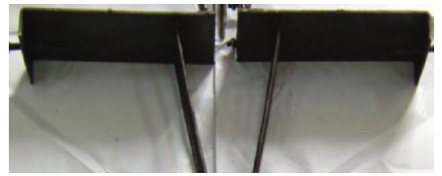
Figure 2: Cutting hole positioning diagram.